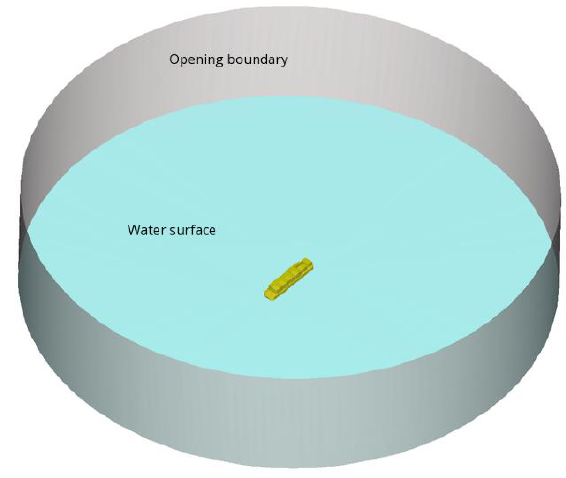
Figure 4. Computational domain for wind loads on FPSO.